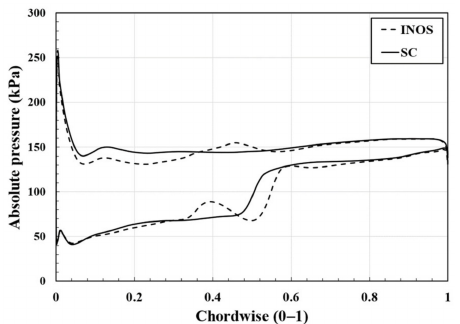
Figure 7. Rotor blade’s loading at 99% blade span at a near-stall condition.